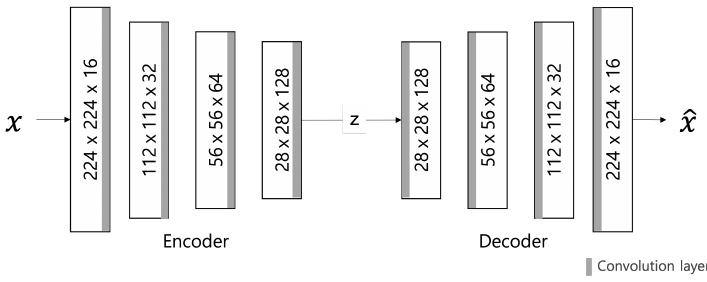
Figure 6. AE model architecture.